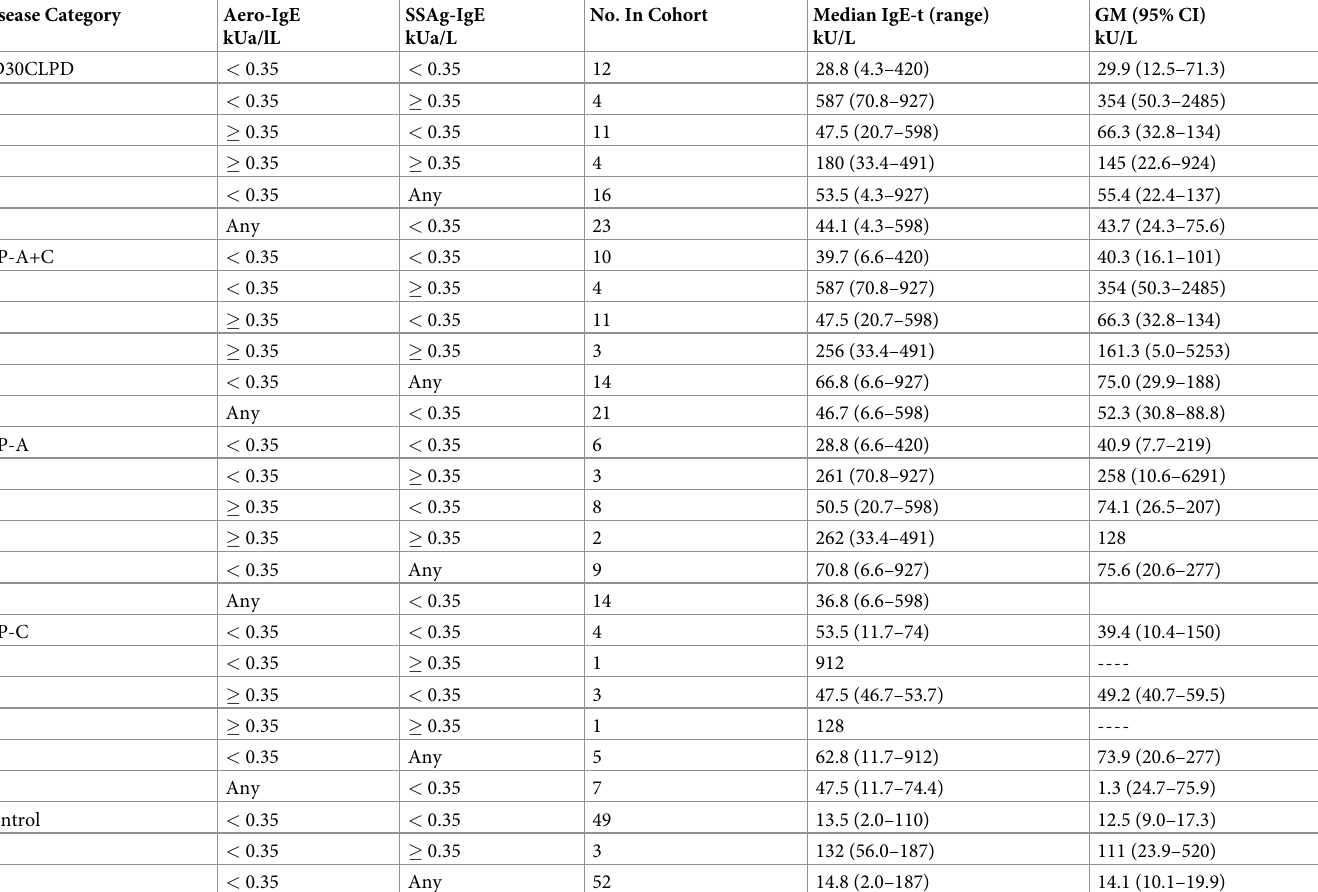
Table 2. Relationship between presence or absence of airborne or staphylococcal superantigen specific IgE and serum total IgE for categories of primary cutaneous CD30+ lymphoproliferative disease. Disease Category Aero-IgE SSAg-IgE kUa/lL